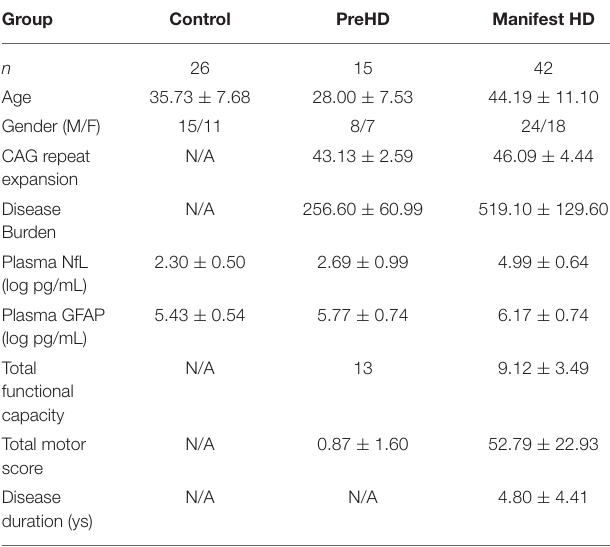
TABLE 1 | Demographic features and intergroup comparison of plasma NfL/GFAP.